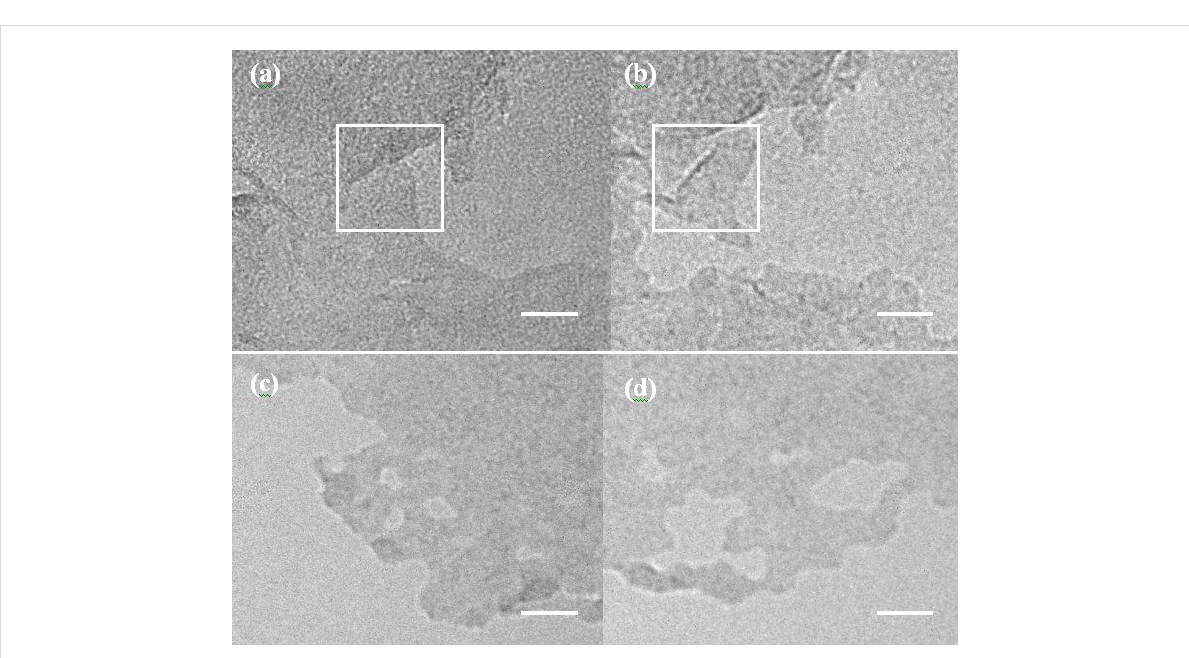
Figure 5: Dynamics in BNNS during TEM measurement a) before and b) after beam. Time between the images is 8 s. Also visible in the sequence is the generation of vacancies within the layer. (c,d) Topological defects are incorporated during this edge reconstruction. On the other edge of the same hole, atoms are removed by the electron beam. Scale bar, 2